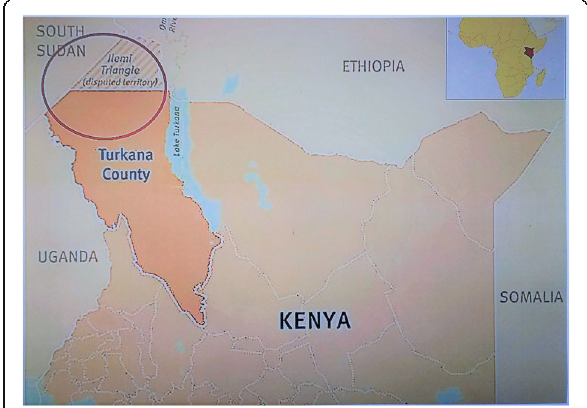
Fig. 1 Turkana map. The circled area indicates the approximate area addressed by the study: (Adapted from World Countries Layer (https://www.arcgis.com/home/index.html)